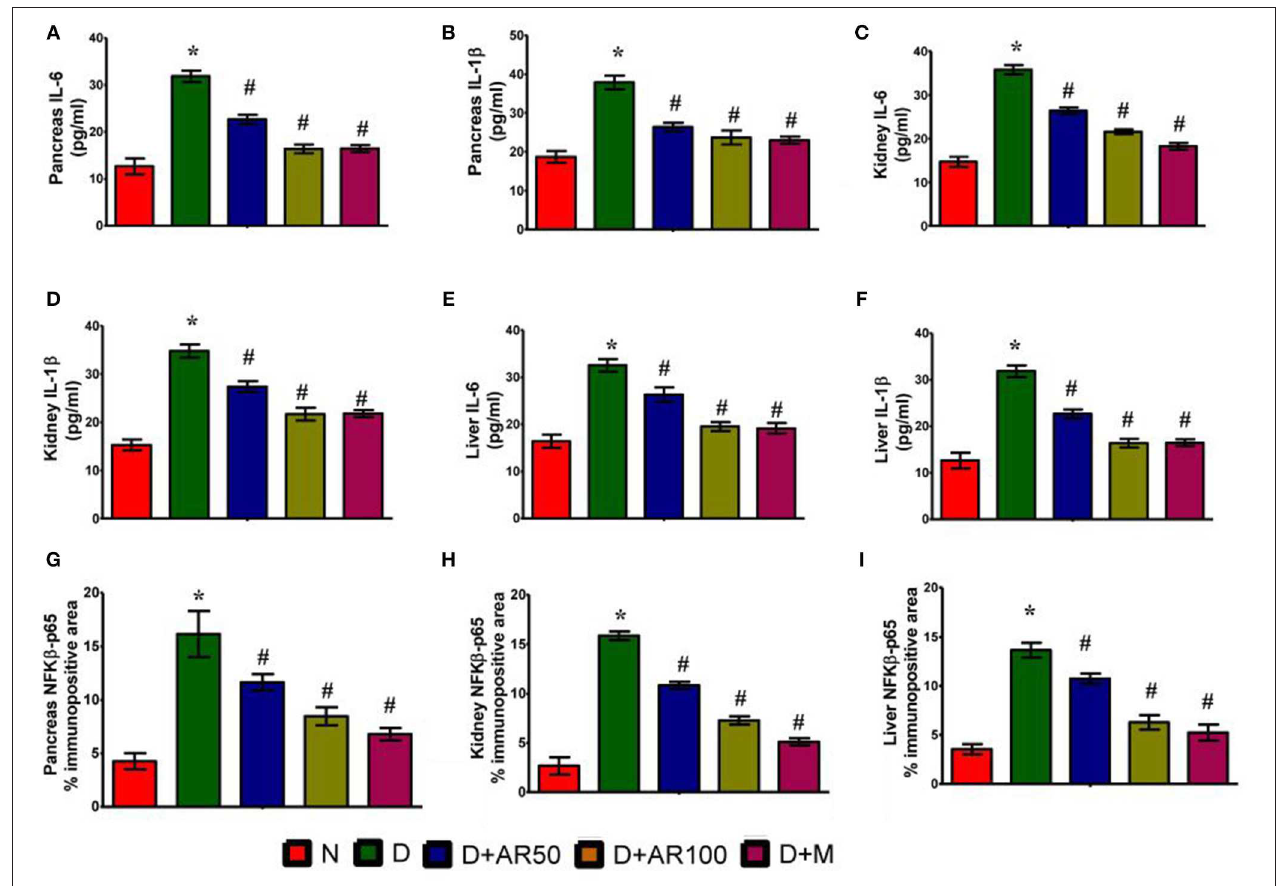
FIGURE 8 | Effect of Annona reticulata L on (A) ELISA pancreatic IL-6 levels (B) ELISA pancreatic IL-1 β levels (C) ELISA kidney IL-6 levels (D) ELISA kidney IL-1 β levels (E) ELISA liver IL-6 levels (F) ELISA liver IL-1 β levels (G) Pancreas NF-K β p65% immunopositive area (H) Kidney NF-K β p65% immunopositive area (I) Liver NF-K β p65% immunopositive